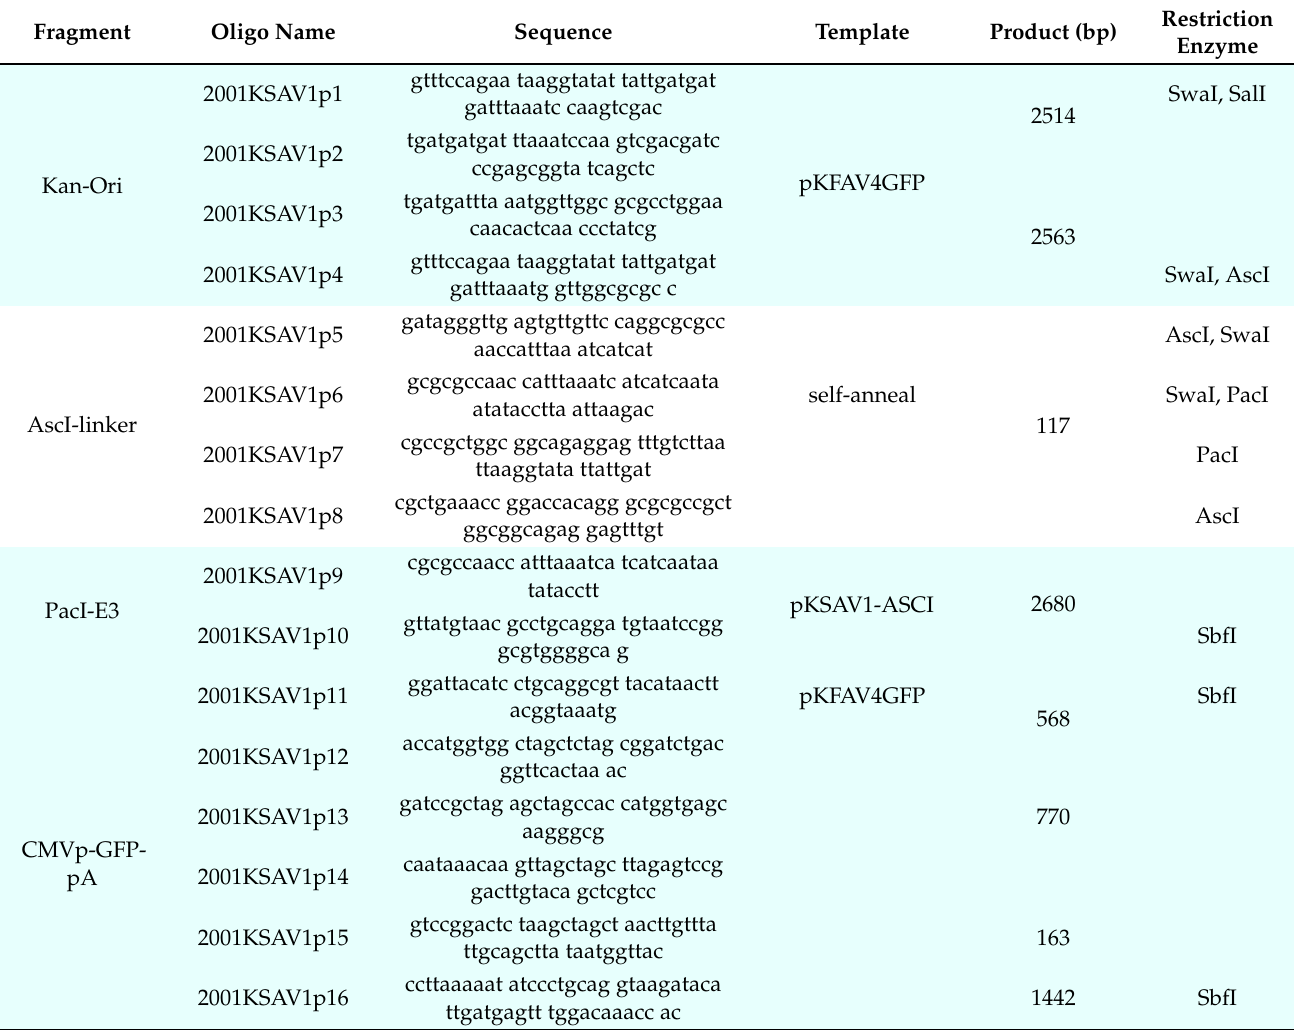
Table 1. Summary information of